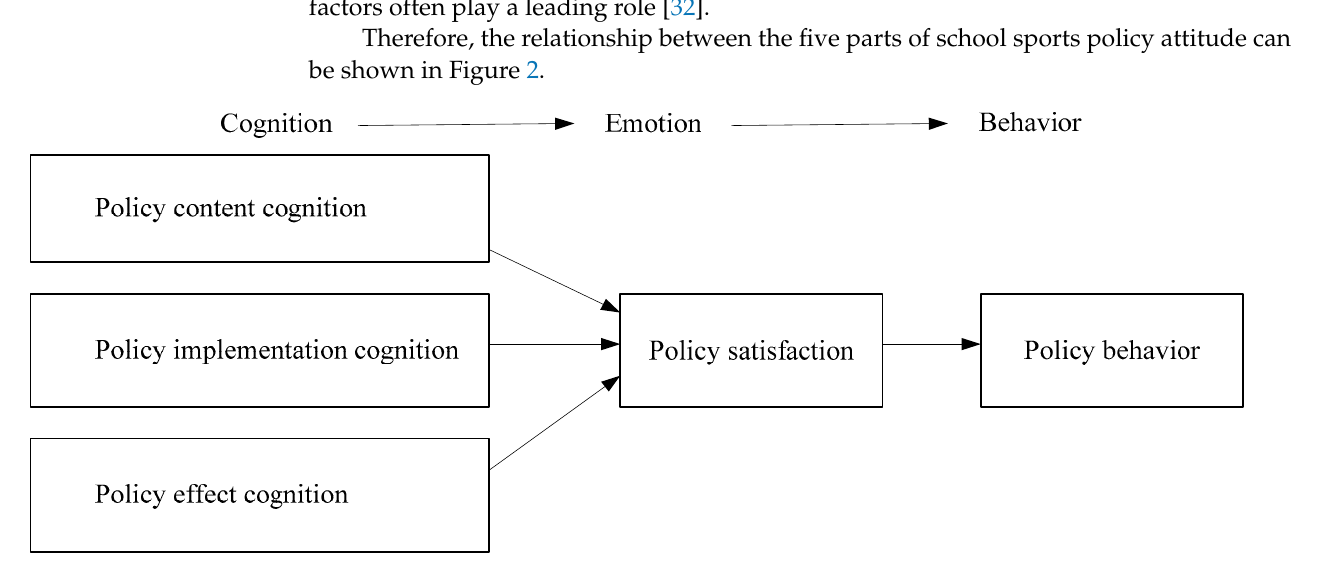
Figure 2. Schematic diagram of psychological mechanism of policy attitude.